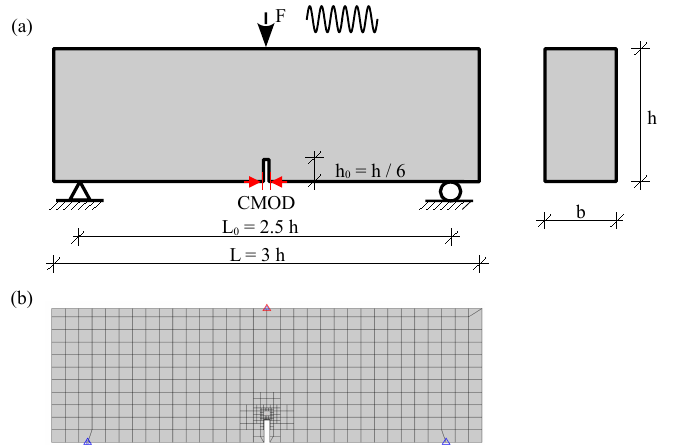
Figure 4. A single-notched concrete beam subjected to a three-point load. ( a ) Geometry, ( b ) initial mesh.